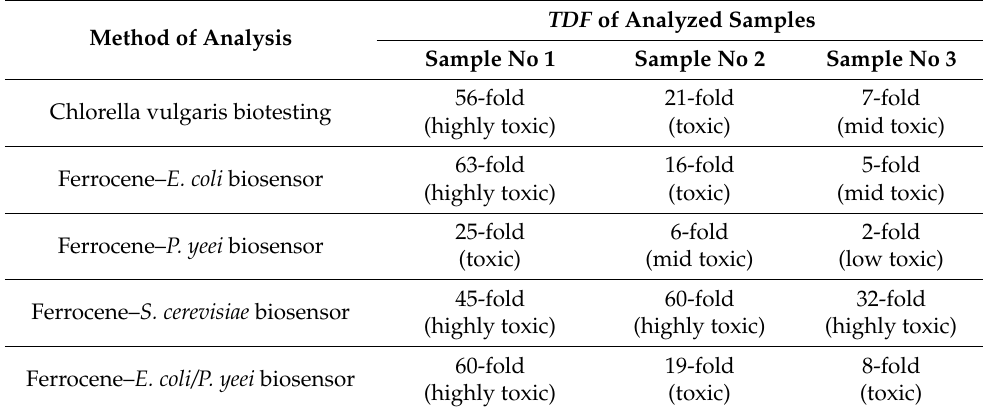
Table 7. The results of calculating TDF for analyzed